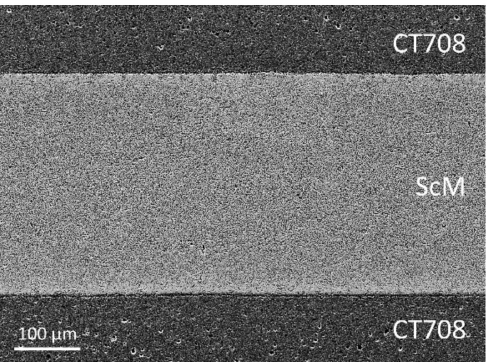
Figure 8. Cross-sectional SEM micrograph of a CT708/ScM ferrite multilayer structure, cofired at 900 ◦